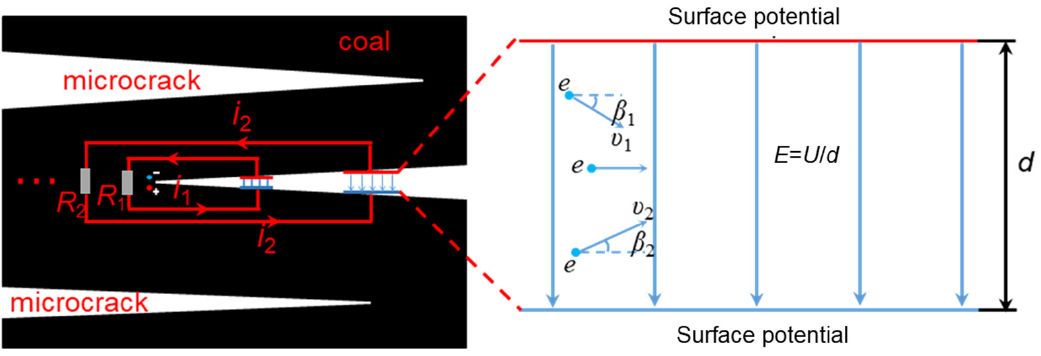
Figure 13. Schematic of a similar parallel-plate capacitor formed at the coal microcrack tip.